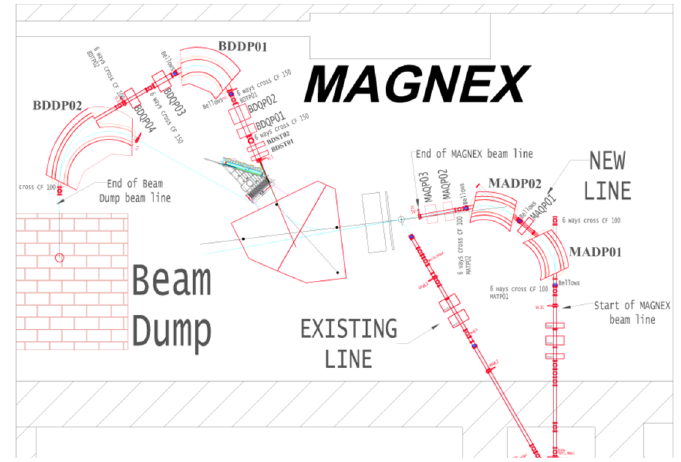
Figure 3. Layout of the new MAGNEX experimental area.